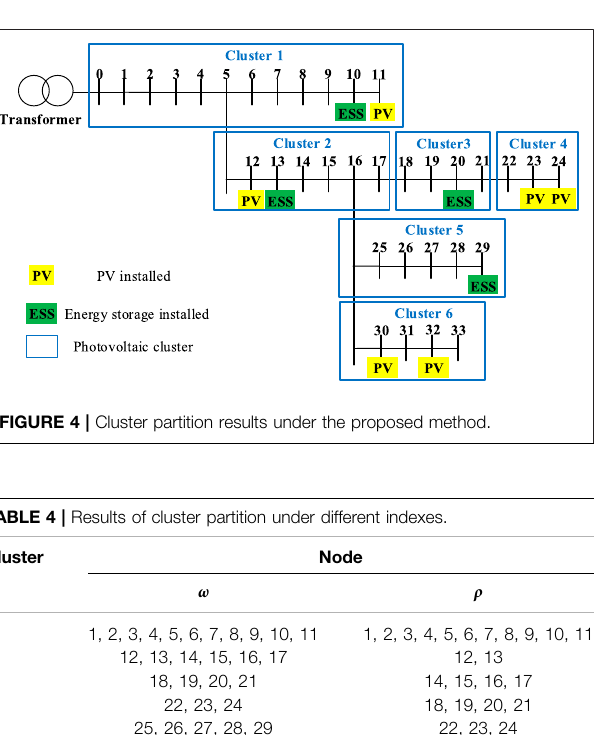
FIGURE 3 | Daily maximum outputs of PVs.